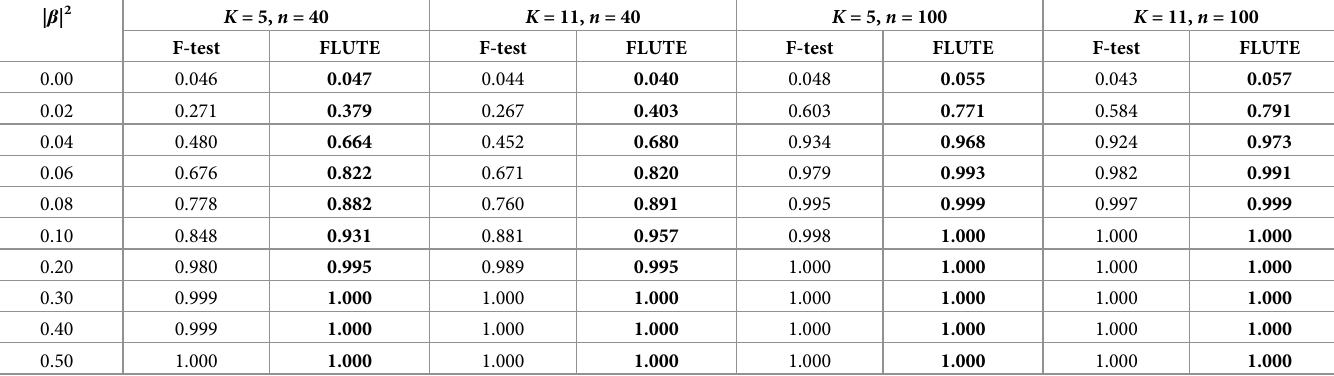
Table 6. Size and power for normal residual at significant level α = 0.05.